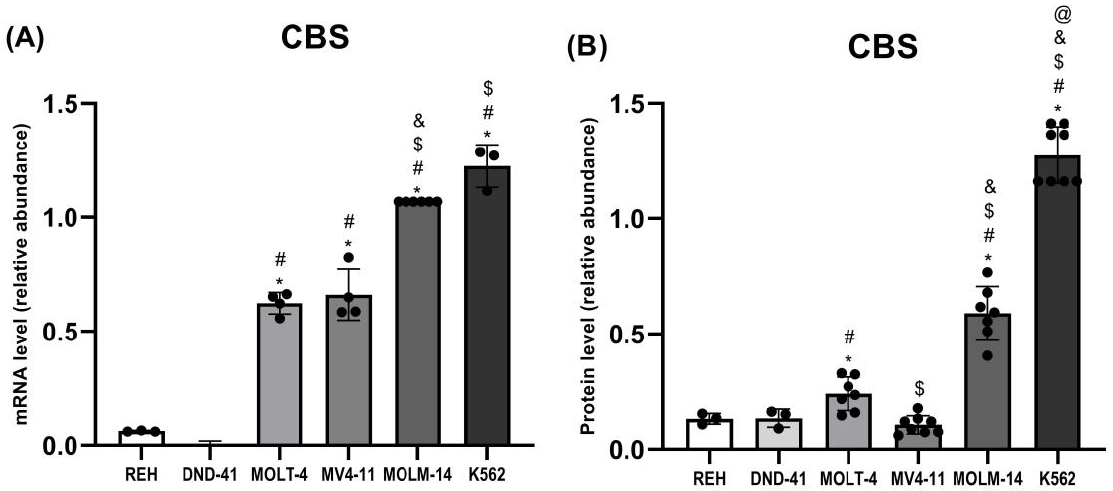
Figure 6. The expression on the mRNA ( A ) and protein ( B ) level of cystathionine β -synthase in leukemia cell lines (REH, DND-41, MOLT-4, MV4-11, MOLM-14, K562). β -Actin was used as a loading control. Quantification of the CBS expression on mRNA level (RT-PCR method) and protein level (Western blotting method) was performed by densitometric analysis of the gels/blots and normalized to the internal loading control. The results are expressed as the mean ± SD of three or more independent experiments. Each mark represents p < 0.05 as followed: * versus REH; # versus DND-41; $ versus MOLT-4; & versus MV4-11; @ versus